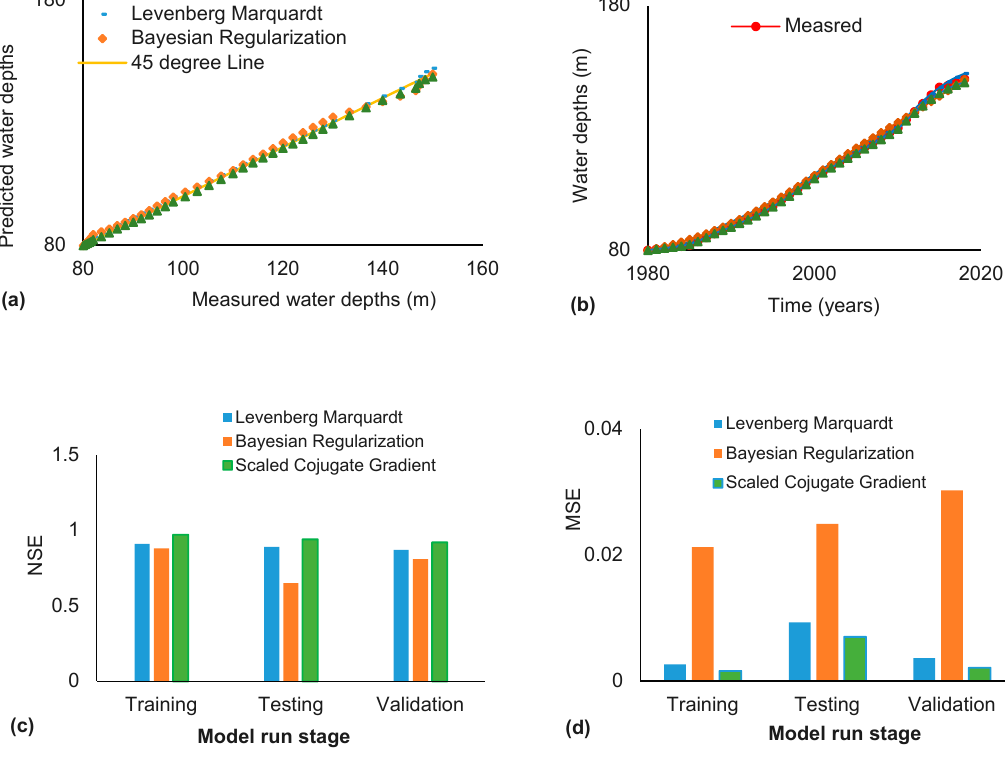
Figure 11. Comparison of the three ANN models. ( a ) Measured vs predicted groundwater levels, ( b ) Measured and predicted groundwater levels with respect to time showing depletion of aquifer, ( c ) NSE values, ( d ) MSE